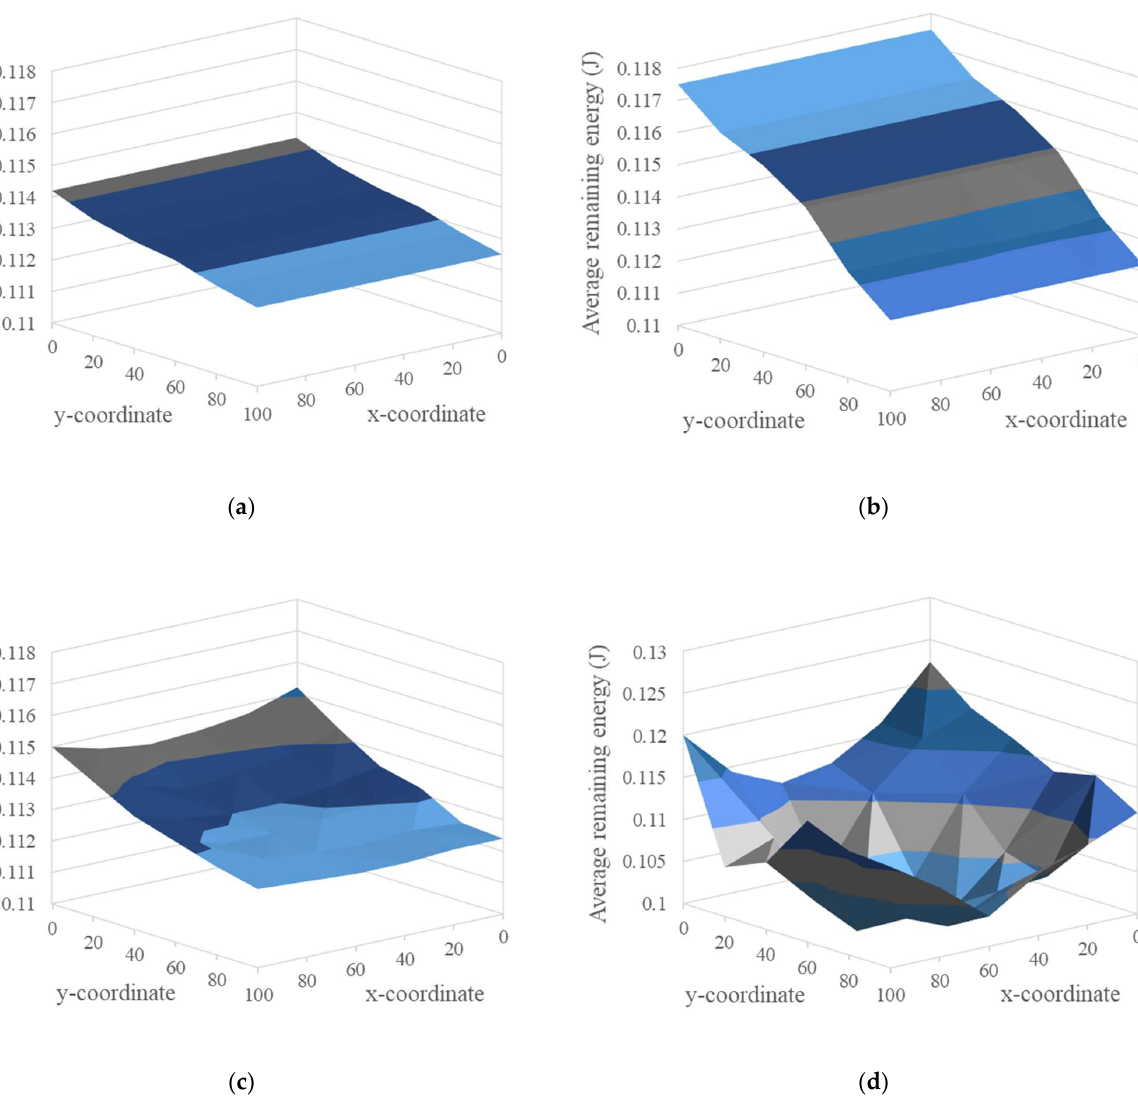
Figure 7. Energy distribution of sensing area when the first node dies: ( a ) GB-PEDAP; ( b ) TBEEP; ( c ) GSTEB; ( d ) PEDAP.